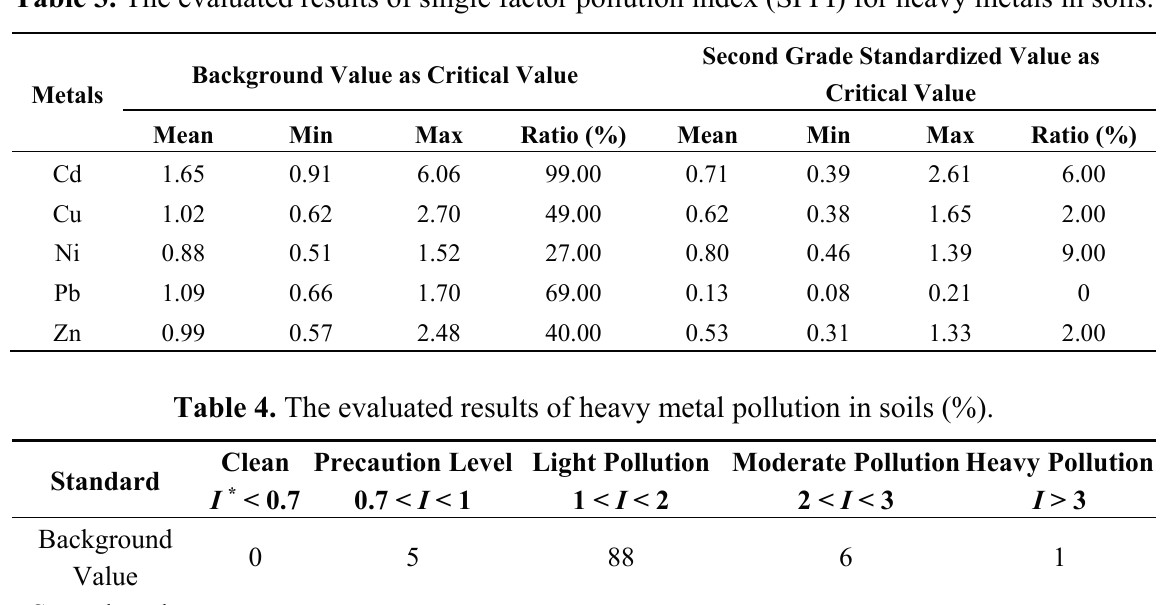
Table 3. The evaluated results of single factor pollution index (SFPI) for heavy metals in soils.